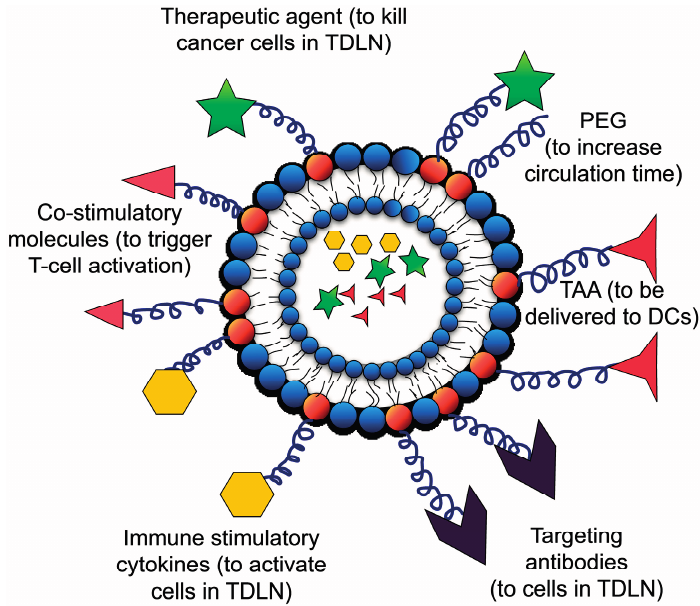
Figure 4. Schematic of liposomes used in TDLN-targeted immunotherapy: Liposomes are composed of lipids with polyethylene glycol (PEG) to increase their circulation time. They can be encapsulated with TAA, immune stimulatory cytokines and therapeutic agents to kill cancer cells. They are functionalized with proteins either by using chelator lipids (his-tagged proteins) or using PEG with maleimide head groups (thiolated proteins). They can be functionalized with immune stimulatory cytokines (e.g., IL-2), co-stimulatory molecules (e.g., anti CD-40 and anti CD-137), therapeutic agents (e.g., TRAIL), targeting antibodies (e.g., anti-DEC205, anti-CD11c to DC and anti-CD57 to NK cells) and TAA (e.g.,